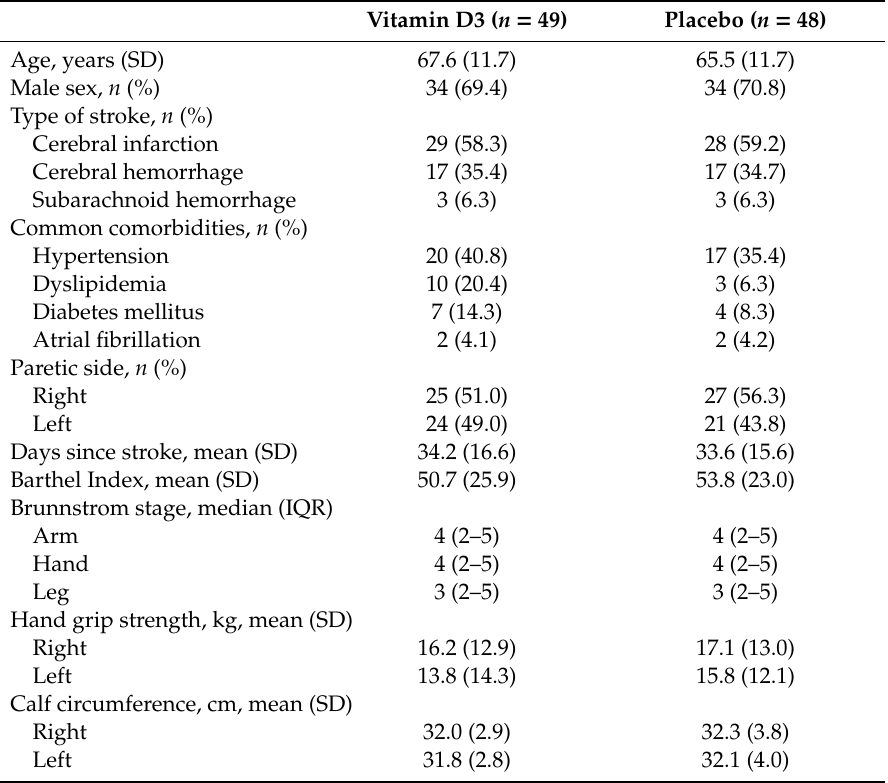
Table 1. Demographic and clinical characteristics of the study population.